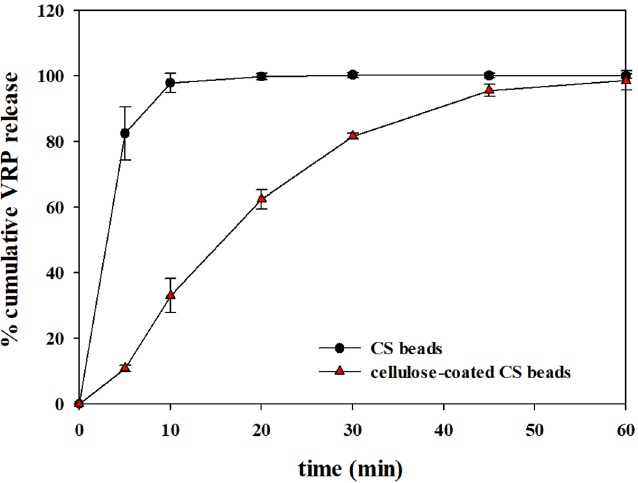
Figure 6. Release patterns of VRP in SGF from CS beads and cellulose-coated CS beads. The in vitro release experiment was performed at 100 rpm and 37 ± 0.5 °C. The concentration of VRP was analyzed by taking a sample of 0.5 ml from 50 ml of SGF solution.